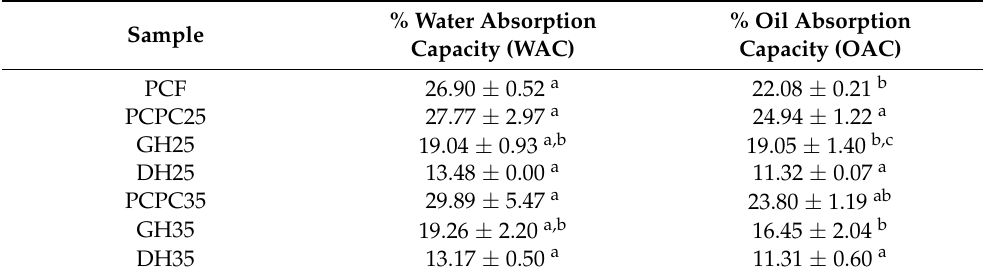
Table 4. Functional properties of purple PCF, PCPC25, PCPC35 and hydrolysates (GH25, DH25, GH35 and